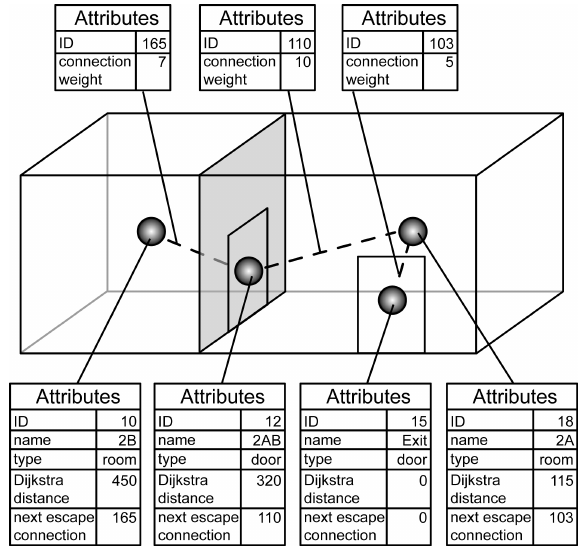
Figure 4. Semantic information represented by attributes.